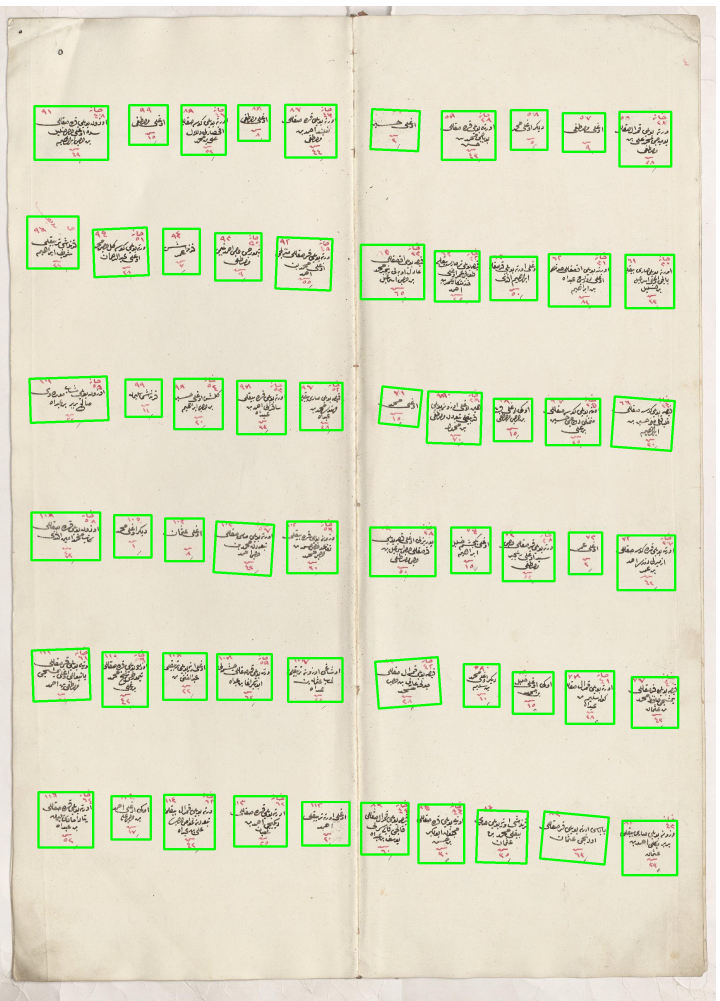
Figure 2. Detected individuals are bounded with green boxes. They include demographic data of individuals. As the pixelwise positions are detected, they are cropped for providing input to the line detection